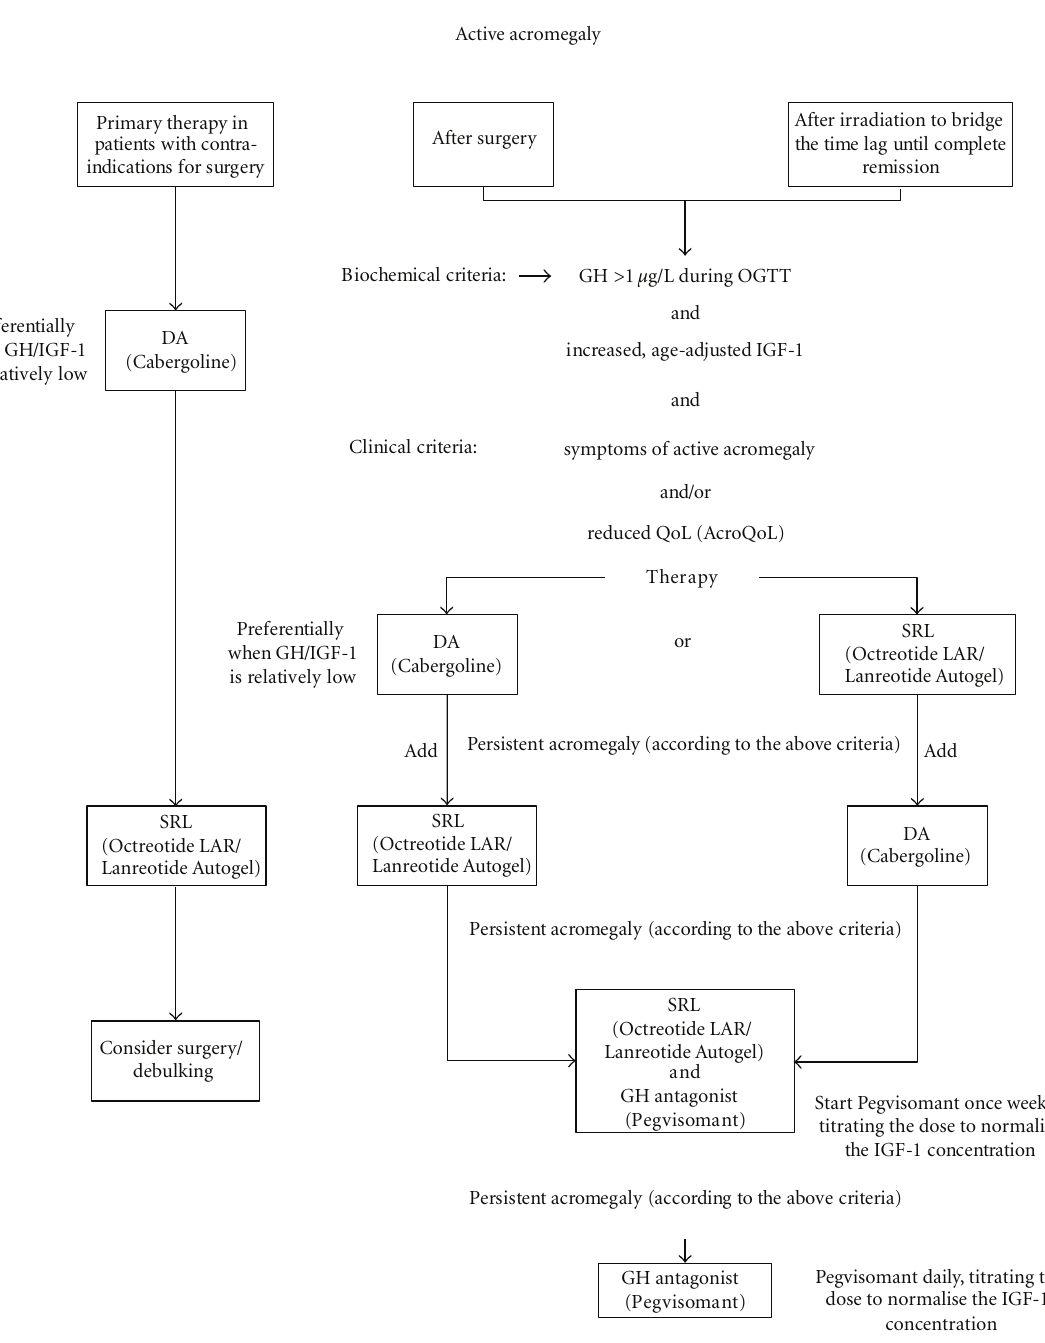
Figure 1: Therapeutic